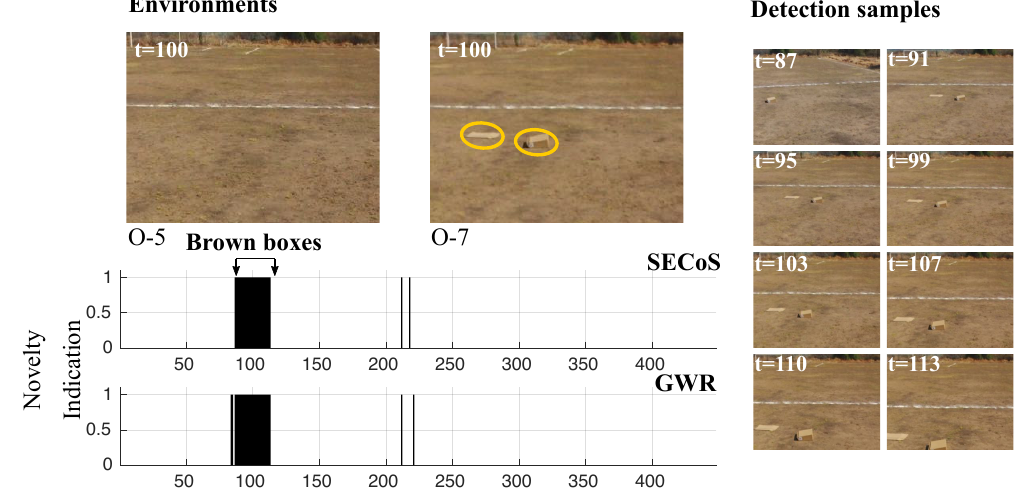
Figure 19. Visual results in novelty detection on dataset D-6 (the brown boxes as the novel objects).